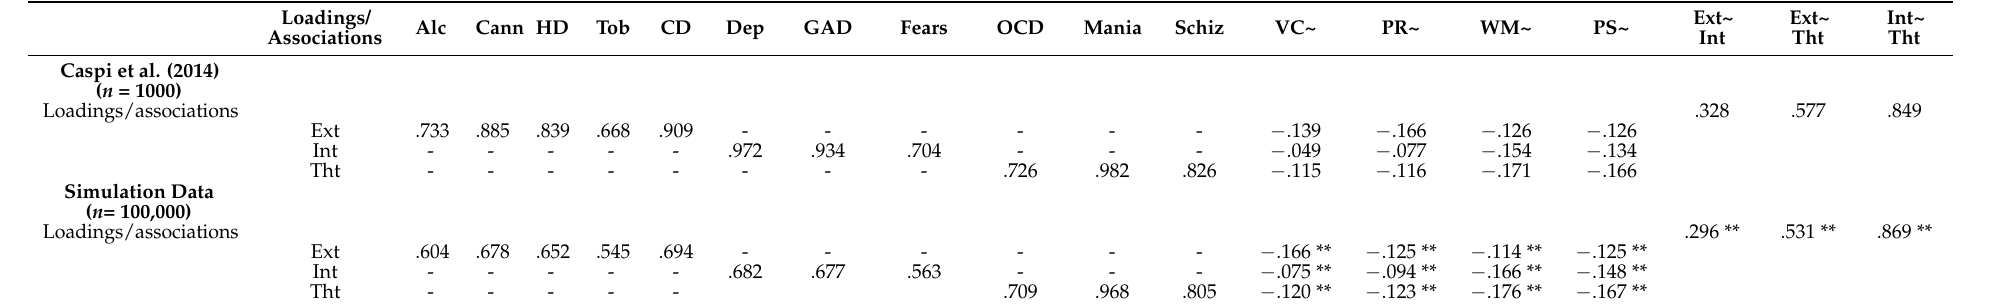
Table 2. Comparison of Loadings, Covariances, and Associations Between Caspi et al. [4] Correlated Model in the Original and Simulated